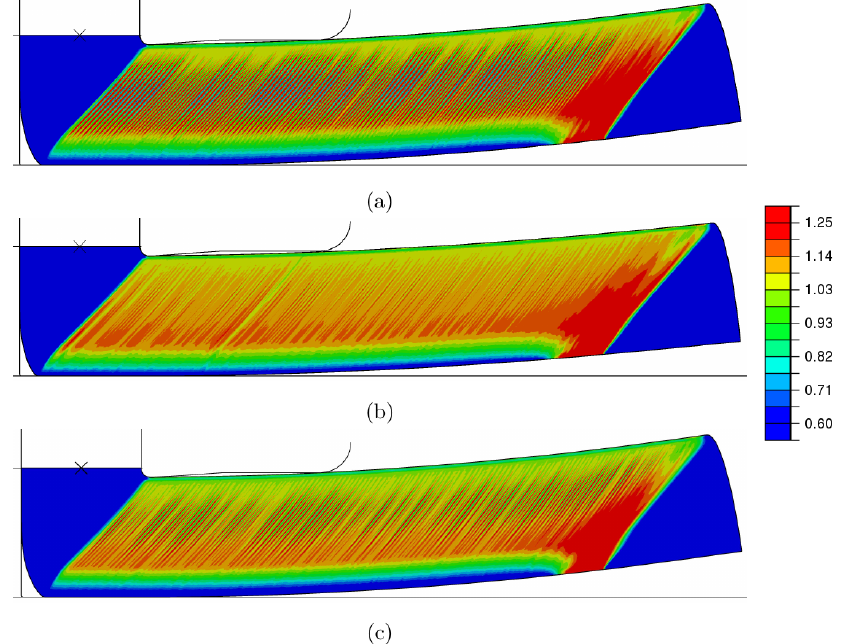
Figure 10. Effective plastic strain s (cf. Equation (9)) for simulations with kinematic hardening with the parameters ( a ) κ − 1 = 200 MPa, κ c kin = 7.5, ( b ) κ − 1 = 100 MPa, κ c kin = 7.5 and ( c ) κ − 1 = 100 MPa, κ c kin = 3.75. In all cases, shear and matrix bands occur.